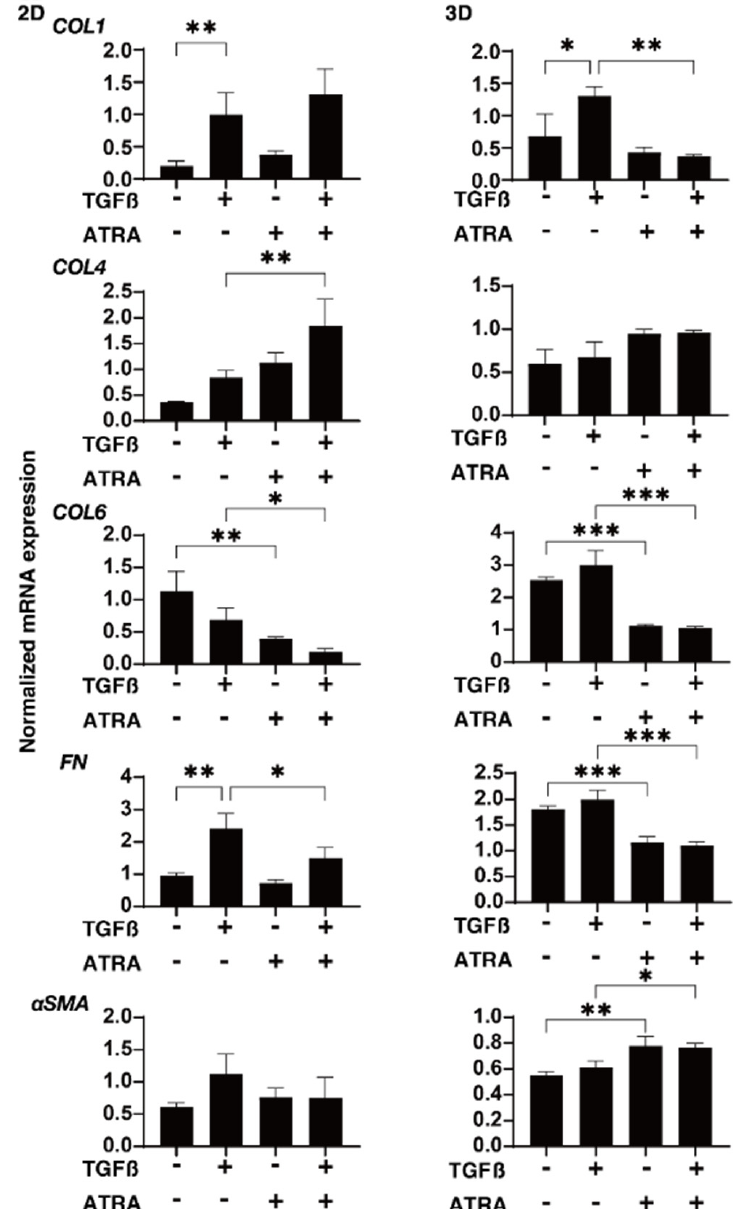
Figure 4. Effects of ATRA on the gene expression of ECM molecules in TGF- β 2-treated 2D- and 3D-cultured HTM cells. Two- and three-dimensionally cultured HTM cells untreated (NT) or treated with 5 ng/mL TGF- β 2 (TGF β ) and/or ATRA (10 µ M) were subjected to quantitative polymerase chain reaction (qPCR) analysis to estimate the expression of mRNA in ECMs (COL1, COL4, COL6, FN, and α SMA). All experiments were performed in triplicate each using freshly prepared 2D HTM cells and 3D HTM spheroids ( n = 15–20, total 45–60) in each experimental condition. Data are presented as the mean ± SEM. * p < 0.05, ** p < 0.01, *** p < 0.005; ANOVA followed by a Tukey’s multiple comparison test.